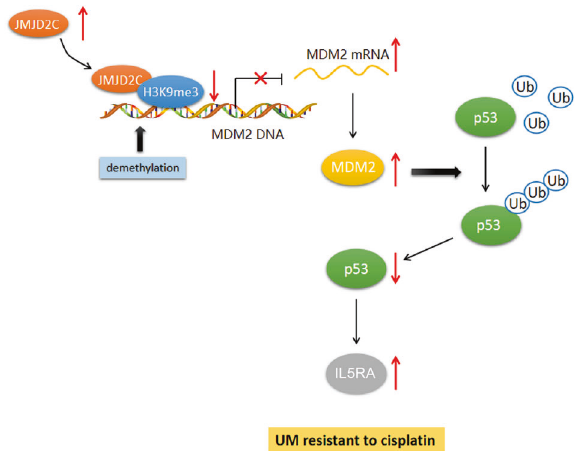
Fig. 7 The molecular mechanism by which JMJD2C affects CDDP resistance in uveal melanoma. JMJD2C promotes the expression